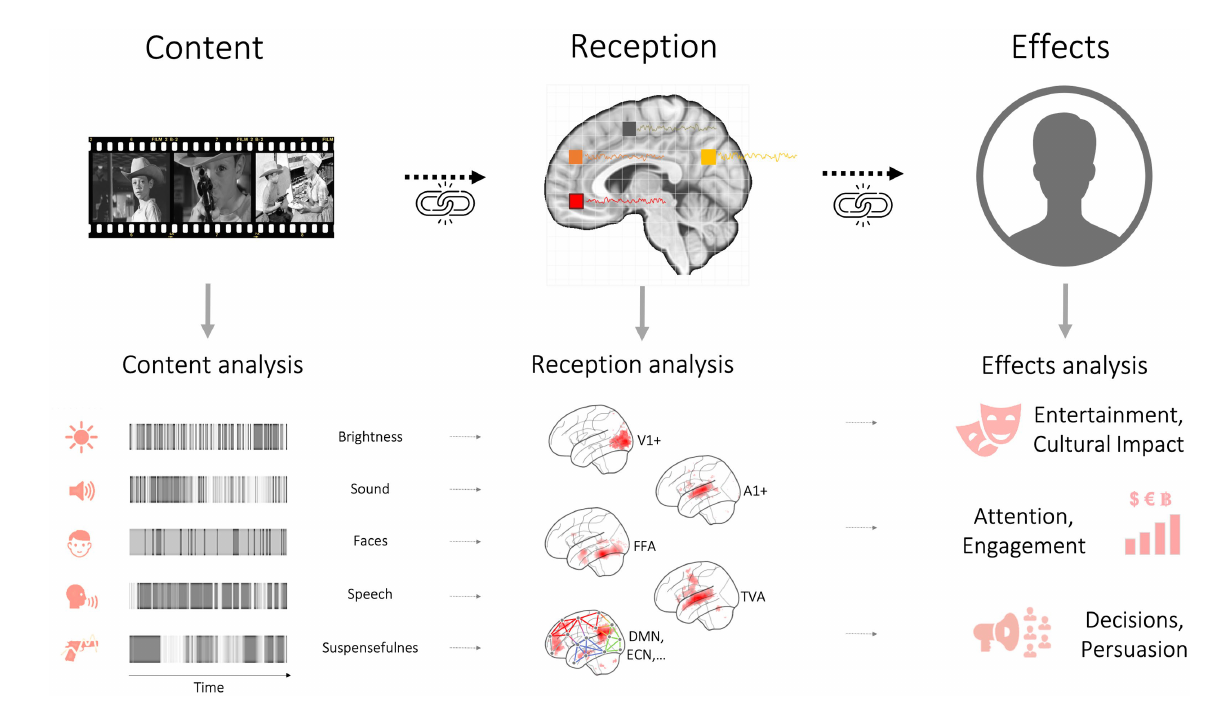
FIGURE 3 The arrow of causality from media content to reception responses to media effects. The bottom left panel illustrates how content analysis quantifies content (e.g., for use as a design matrix), allowing to map out brain systems responding to specific content elements. These can then be linked to effects of media consumption. Of note, reception responses to an incoming (causal) media stimulus can also be modulated by receiver state, background knowledge, beliefs, and so